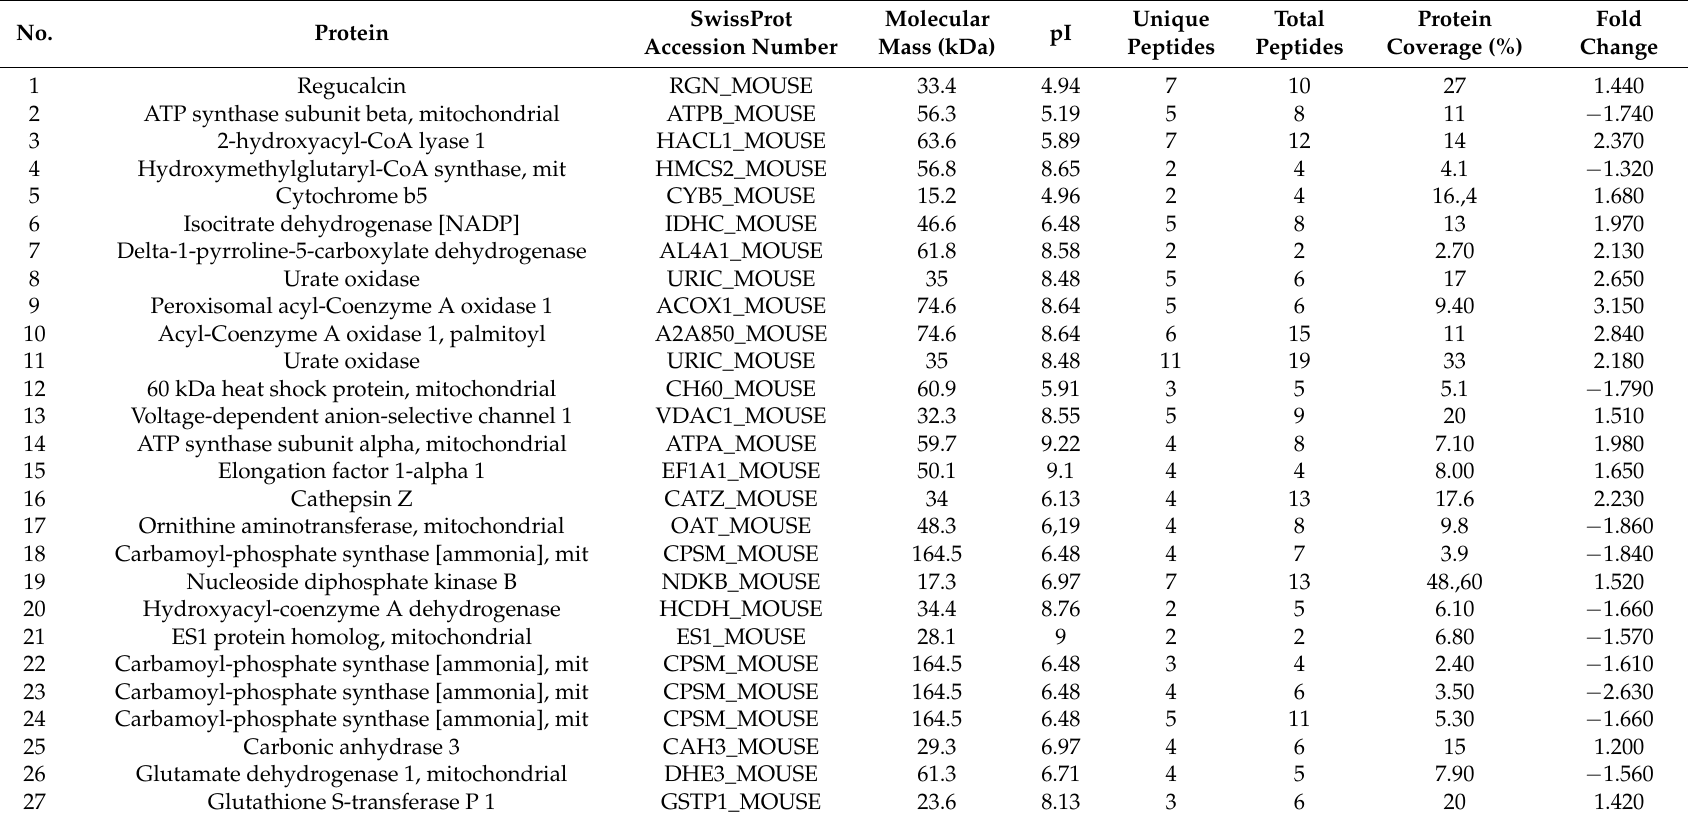
pI indicates isoelectric point; * p < 0.05; n = 3 per